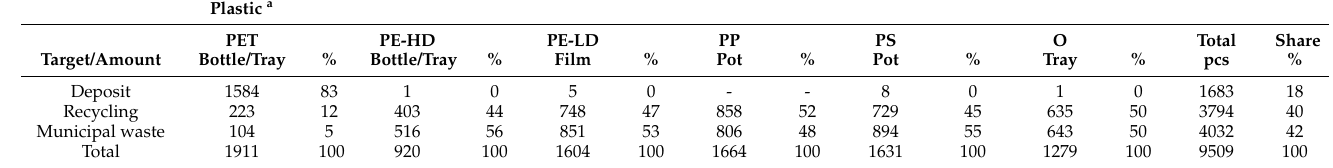
Table 2. Quantitative summary of used plastic packages based on both end-use and type of